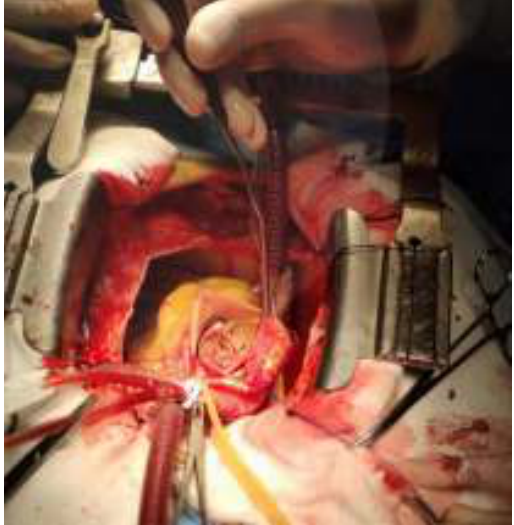
Figure 3: Inside of Aortic Aneurysm after AVR with Biologic Prosthesis